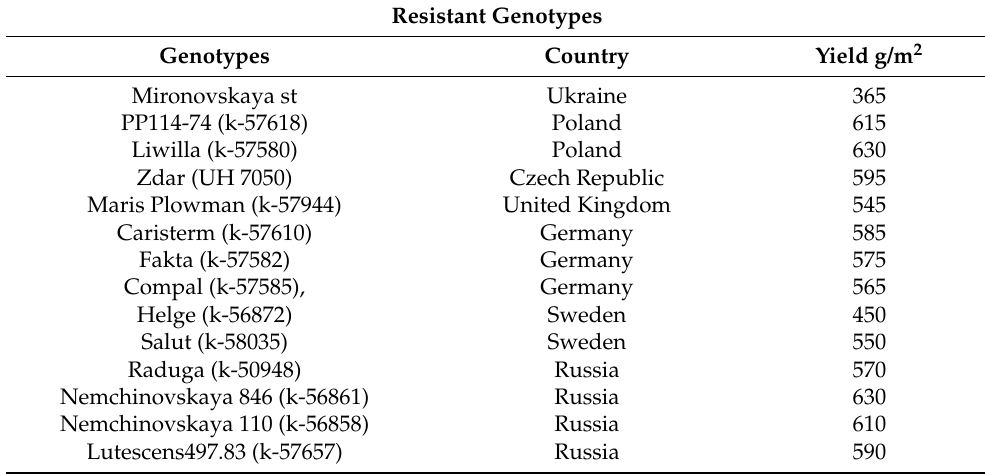
Table 1. Yield of the resistant genotypes